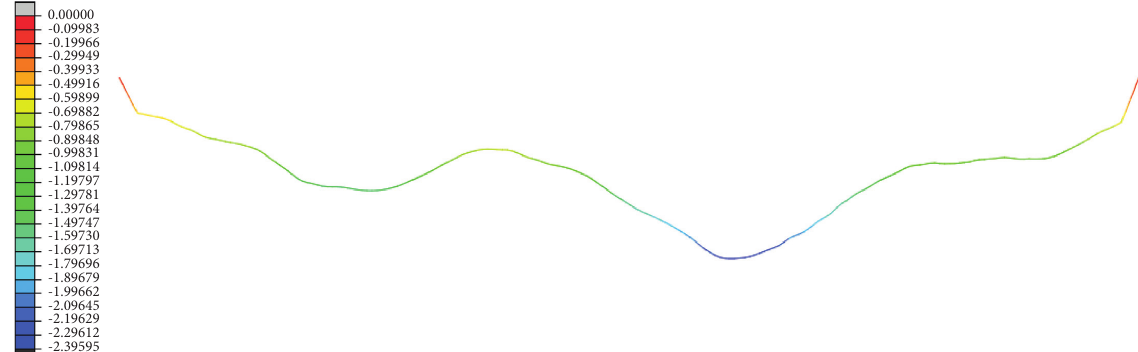
Figure 3: Displacement nephogram at a certain moment in the stable vibration stage (scaling coefficient: